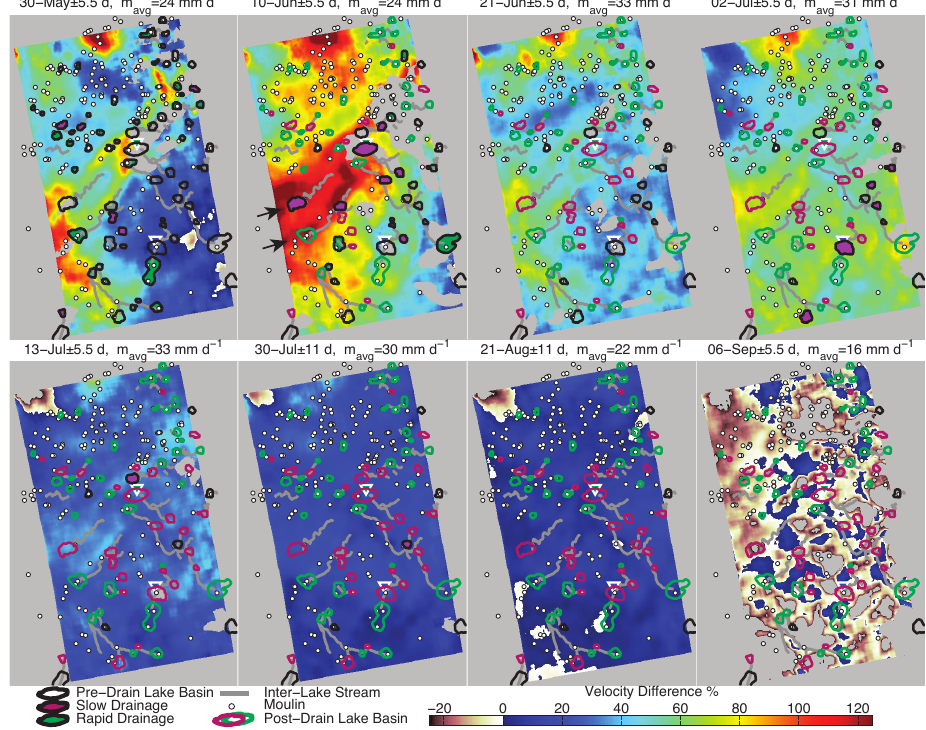
Fig. 4. Difference between summer and winter velocity for 2010. Also plotted are the surface features shown in Fig. 2 with the same color coding as in Fig. 3. Mean daily melt estimates, m avg , determined using RACMO2 (van Angelen et al., 2012) are shown beside the corresponding date for each map. Note maximum of speedup on 10 June is located just downglacier of two major surface streams indicated by black arrows (see high-resolution version in